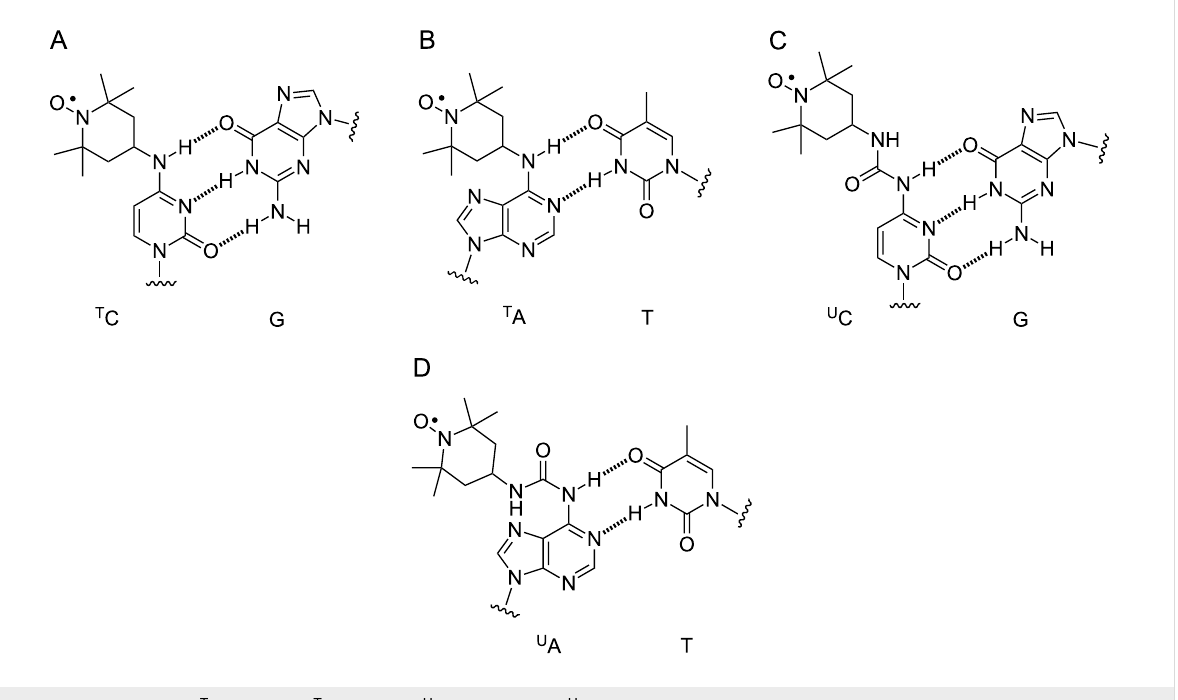
Figure 1: Base pairing of T C with G (A), T A with T (B), U C with G (C) and U A with T